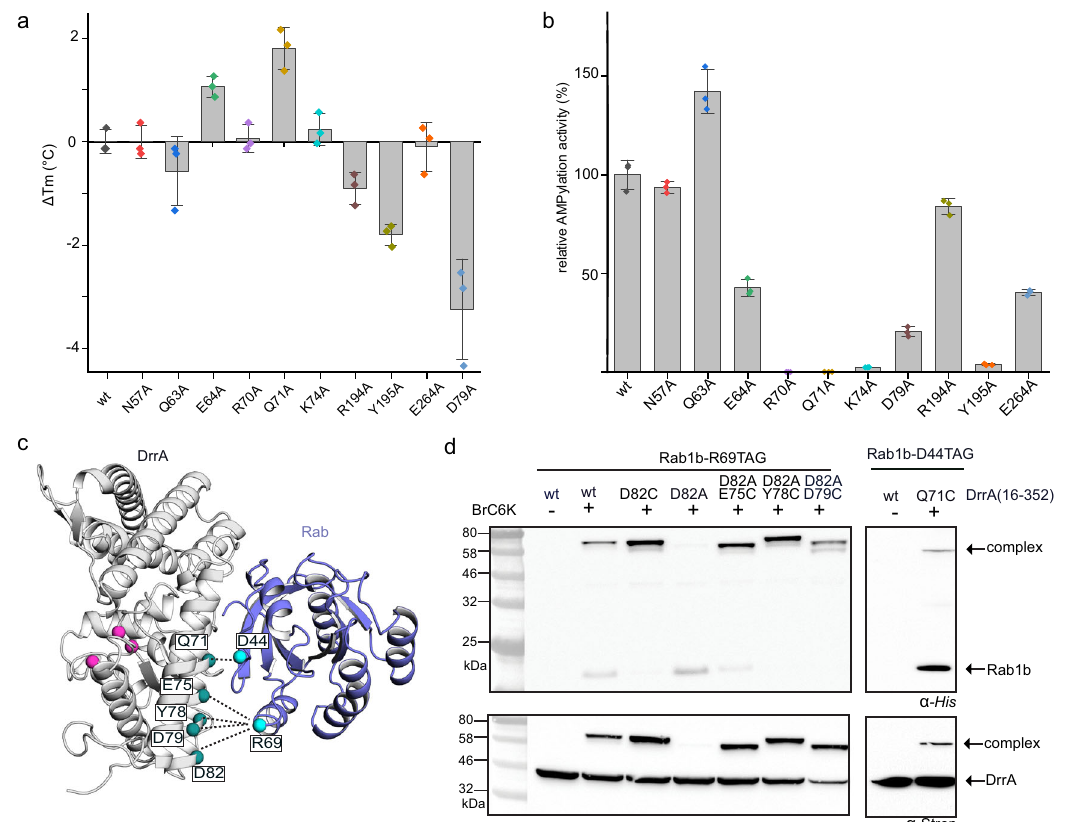
Fig. 3 Con fi rmation of the NC-RBS complex interface. a Melting point (Tm) determination of DrrA and DrrA alanine mutants by circular dichroism (CD). The melting point of wt DrrA is 60.1 °C. Data are means ± standard error of the mean (SEM) from three independent experiments. b Determination of Rab1b-AMPylation rates in vitro by DrrA with mutations in the non-conventional site. The k cat / K M value of wt DrrA is 8.0 × 10 5 M − 1 s − 1 (± 2.0× 10 4 M − 1 s − 1 ). Data are means±standard error of the mean (SEM) from three independent experiments. c Representation of selected interactions for in cellulo crosslinking in E. coli . Pink spheres are the catalytic Asp residues of DrrA. d Pairwise BrC6K (within Rab1b) and Cys mutations (within DrrA) based on the DrrA:TReND-1:Rab complex lead to covalent crosslink formation, if the BrC6K-based thioether linker is able to bridge the Rab1b-DrrA interface, as observed by α -His6 and α -Strep western-blotting. Source data are provided as a Source Data fi